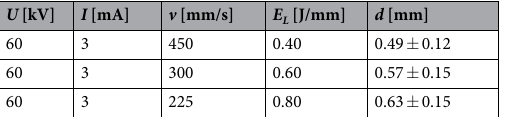
Table 1. Beam parameters for building the samples: voltage U , electron beam current I , electron beam speed v , line energy E L and resulting strut thickness d